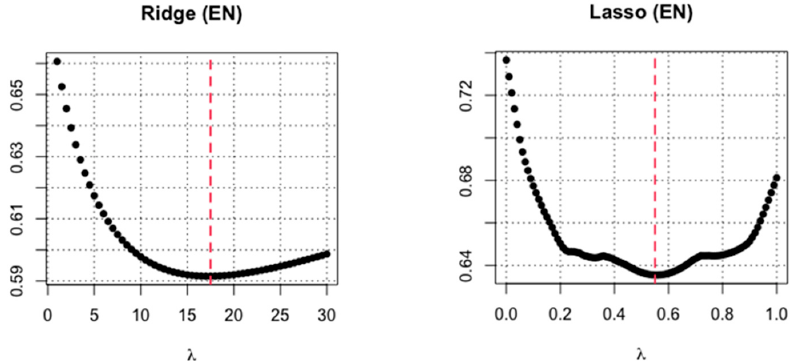
Figure 4. Optimization of predictive models (the red line indicates the optimal model).